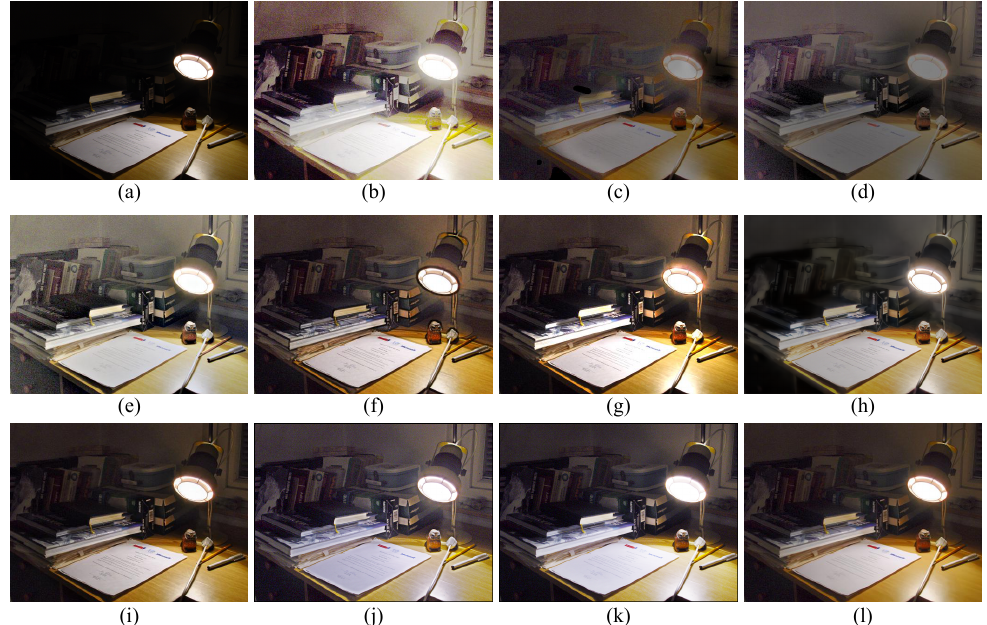
Figure 4. Visual comparison between low-light image enhancement results in the exemplar